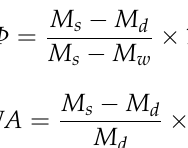
Figure 5. Testing system for vacuum saturation method.